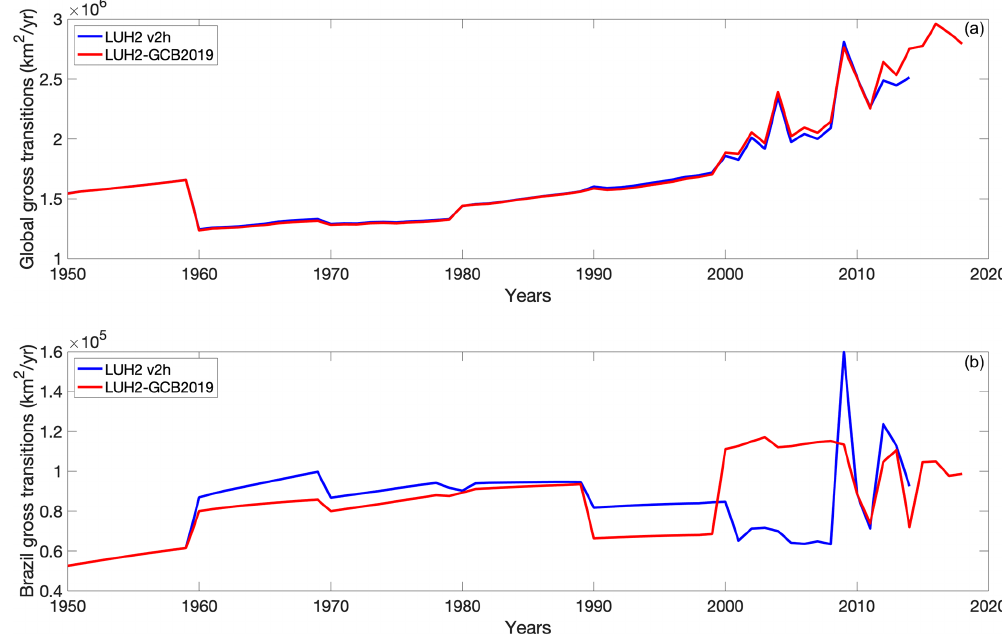
Figure 4. (a) Global and (b) Brazilian annual gross transitions for LUH2 v2h and LUH2-GCB2019 for the years 1950–2014/2018.